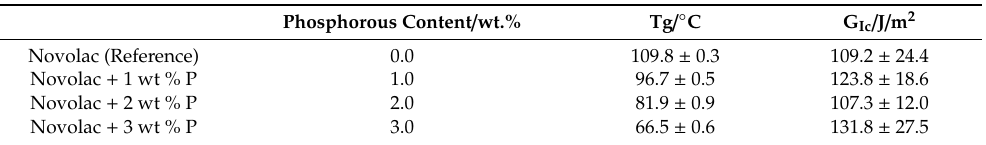
Table 1. Adjusted phosphorous content, glass transition temperature and fracture toughness of DOPO modified epoxy